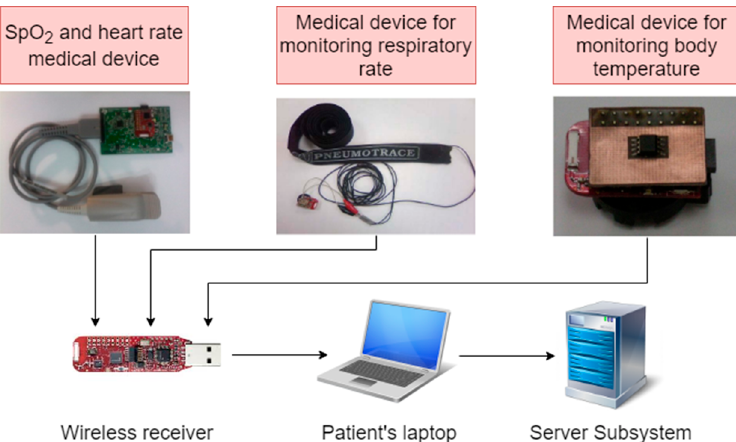
Figure 5. Wireless body area network (WBAN) of telemonitoring module used for the acquisition of the different physiological parameters of patients: SpO 2 , HR, RR, and BT.